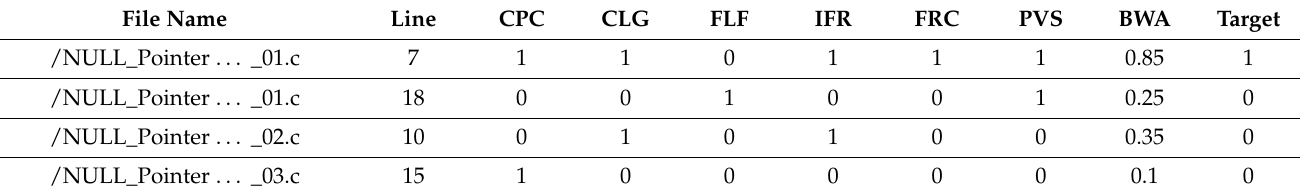
Table 4. Example data of integrating analysis results from each tool for Alarm Classification model.